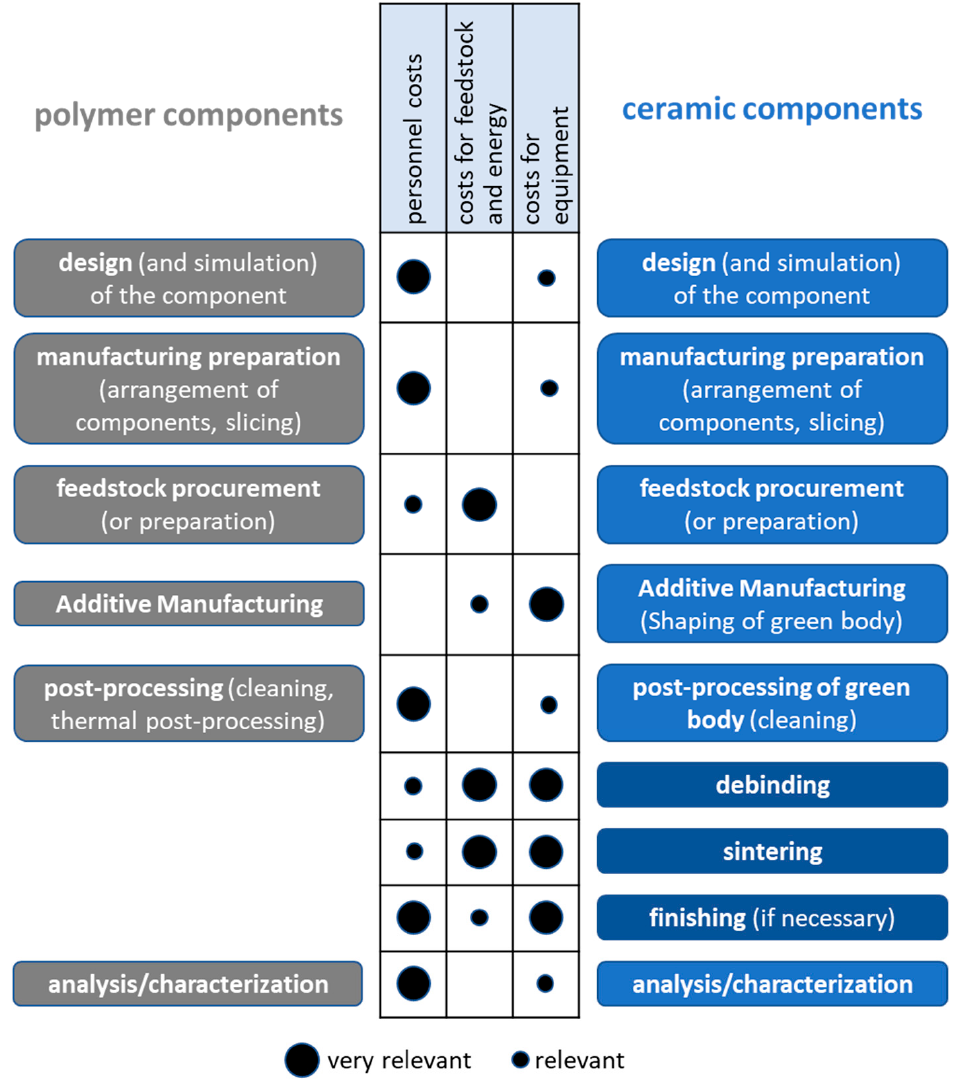
Figure 1. Process steps and relevant cost categories for AM of polymer and ceramic components.